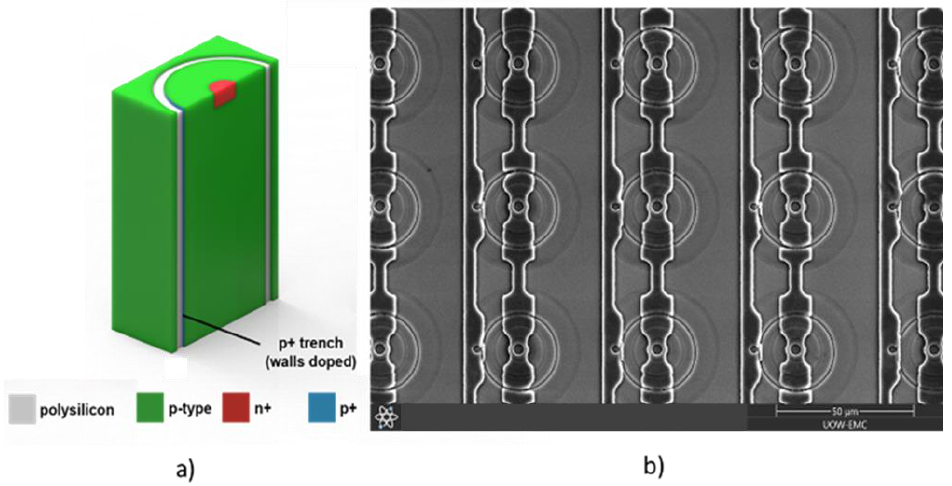
Figure 4. ( a ) A simplified schematic of the trenched 3D Mushroom microdosimeter with a p + -doped trench filled with polysilicon and planar n + core (trenched-planar) and ( b ) SEM image of the trenched 3D Mushroom microdosimeter with a planar core SV array [22].